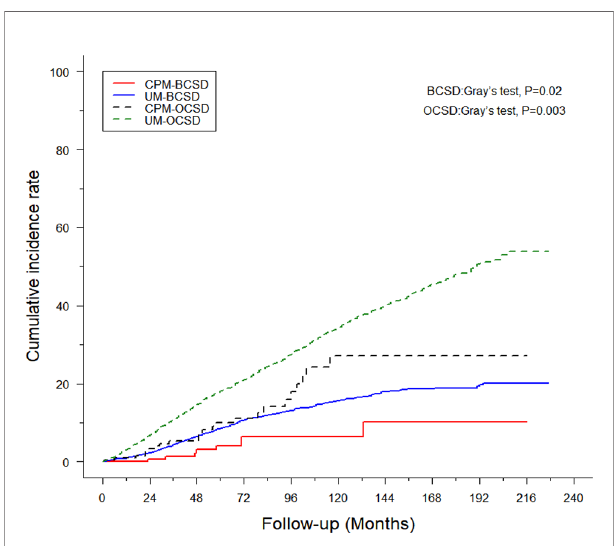
FIGURE 3 | Cumulative incidence of breast cancer-speci fi c death (BCSD) and other cause-speci fi c death (OCSD) in the CPM group and UM group.